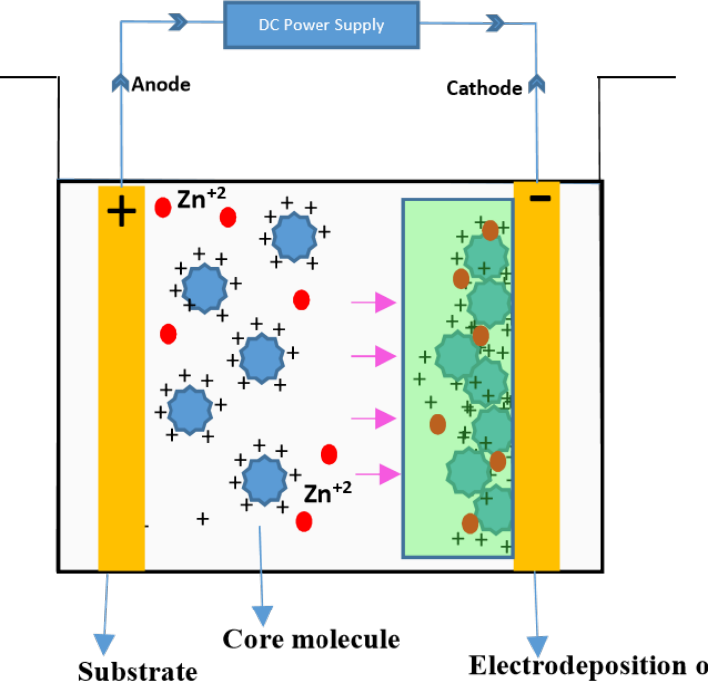
Figure 9. Electrolytic co-deposition of microcapsules